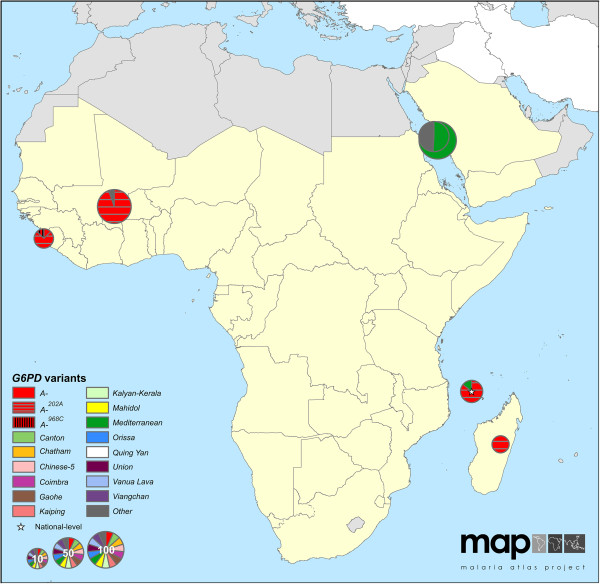
G6PDd variant proportion map: Africa+ (map series 1). Map includes six surveys with a mean sample size of 43 (range: 5-110). One survey was mapped at the national level. (See Figure 
2 for full legend).